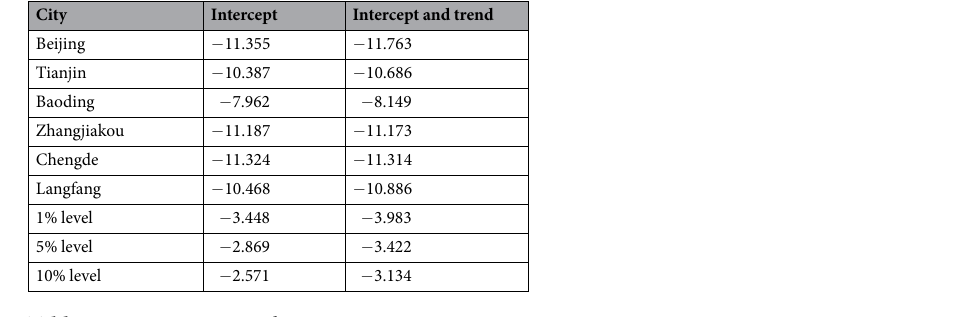
Table 3. Unit root test results.